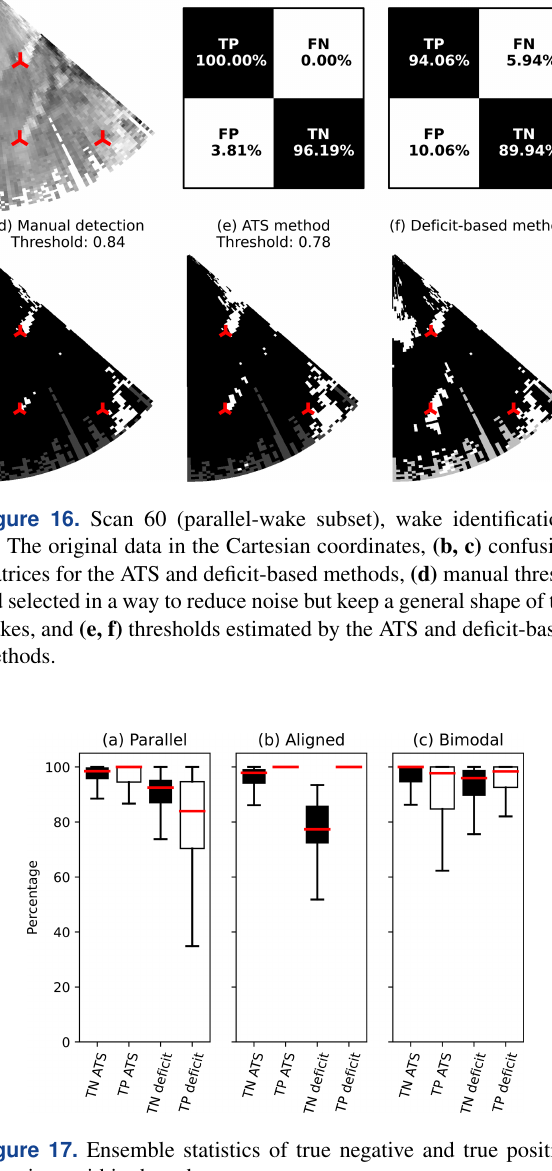
Figure 17. Ensemble statistics of true negative and true positive detections within the